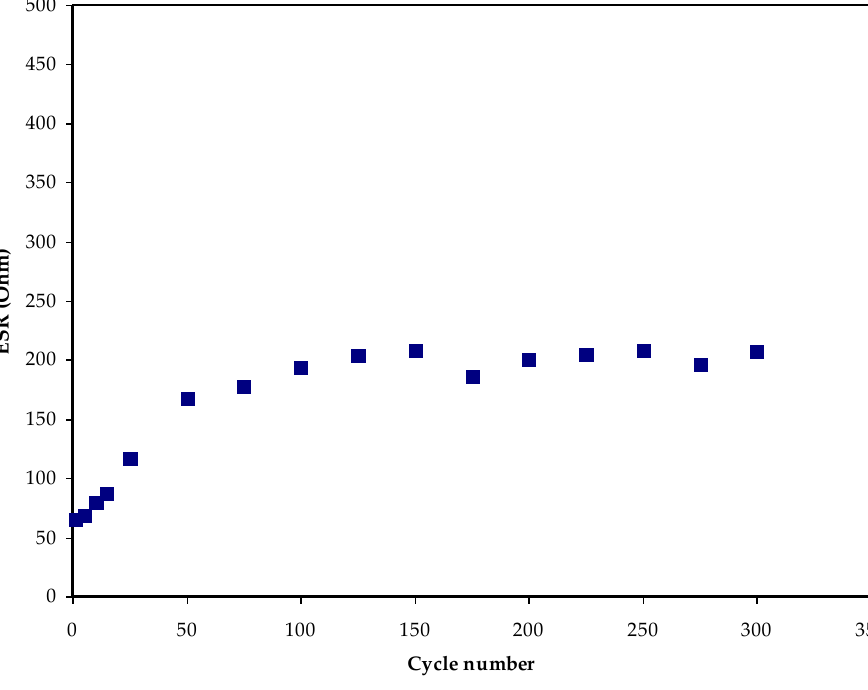
Figure 7. The equivalence series resistance ESR pattern for the fabricated EDLC.